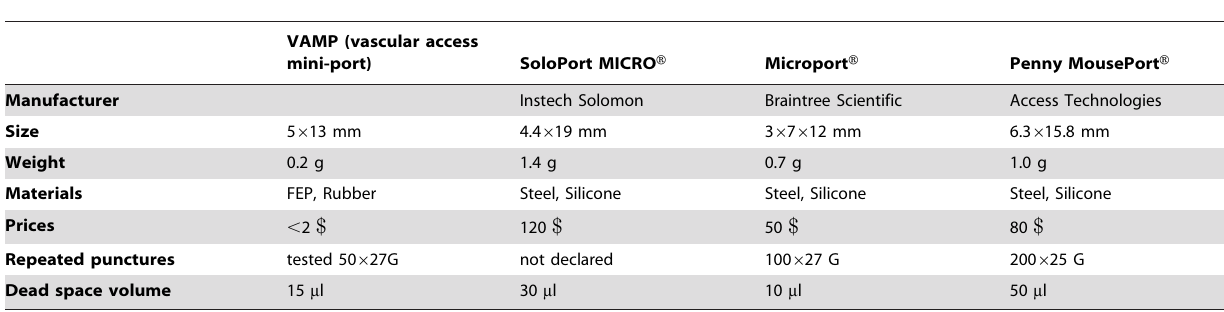
Table 1. Comparison of the custom-made (VAMP) and the commercially available vascular access ports for mice.